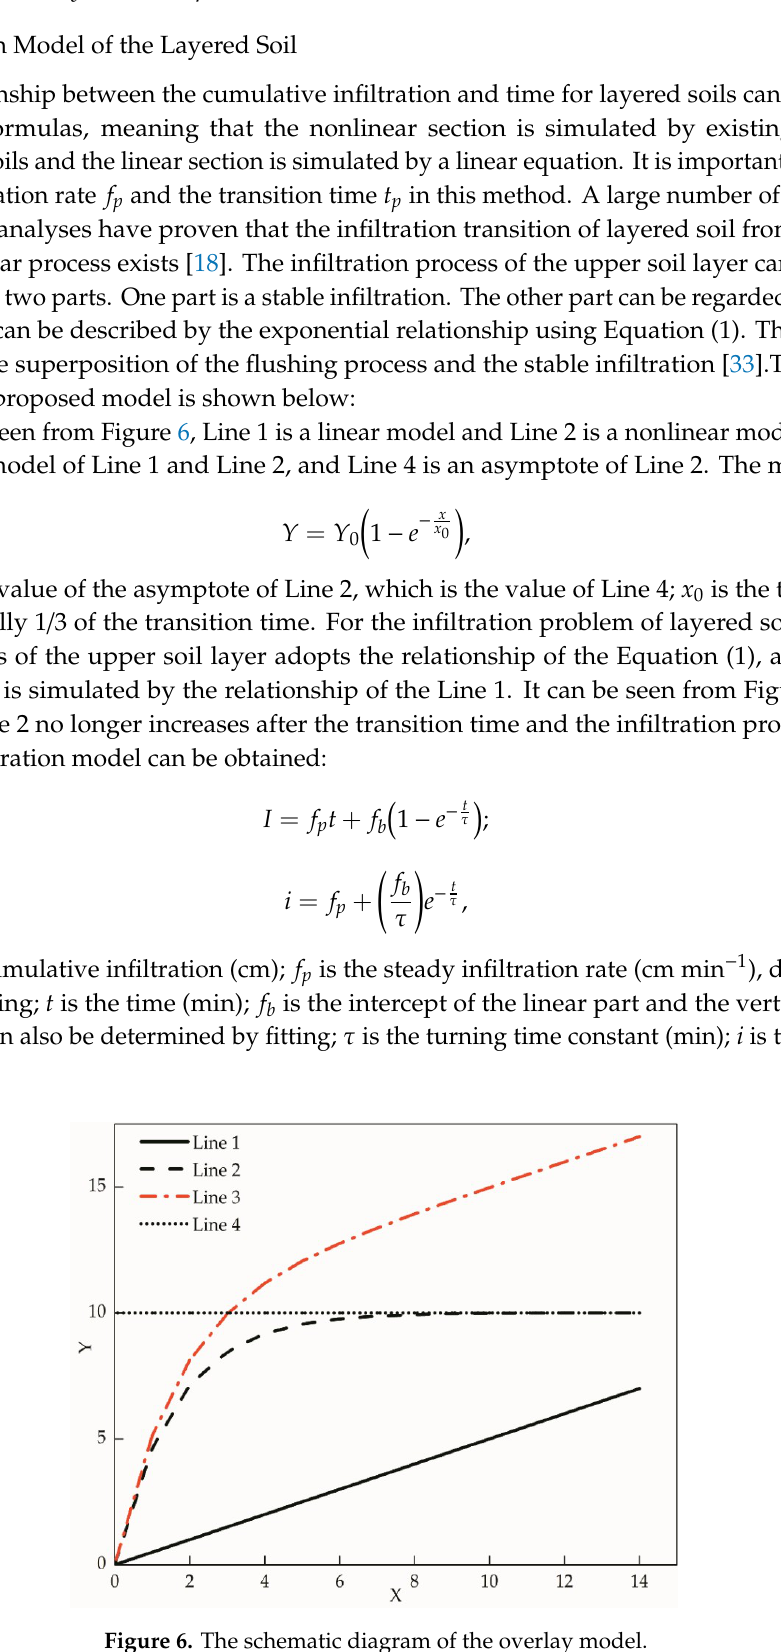
Figure 6. The schematic diagram of the overlay model.